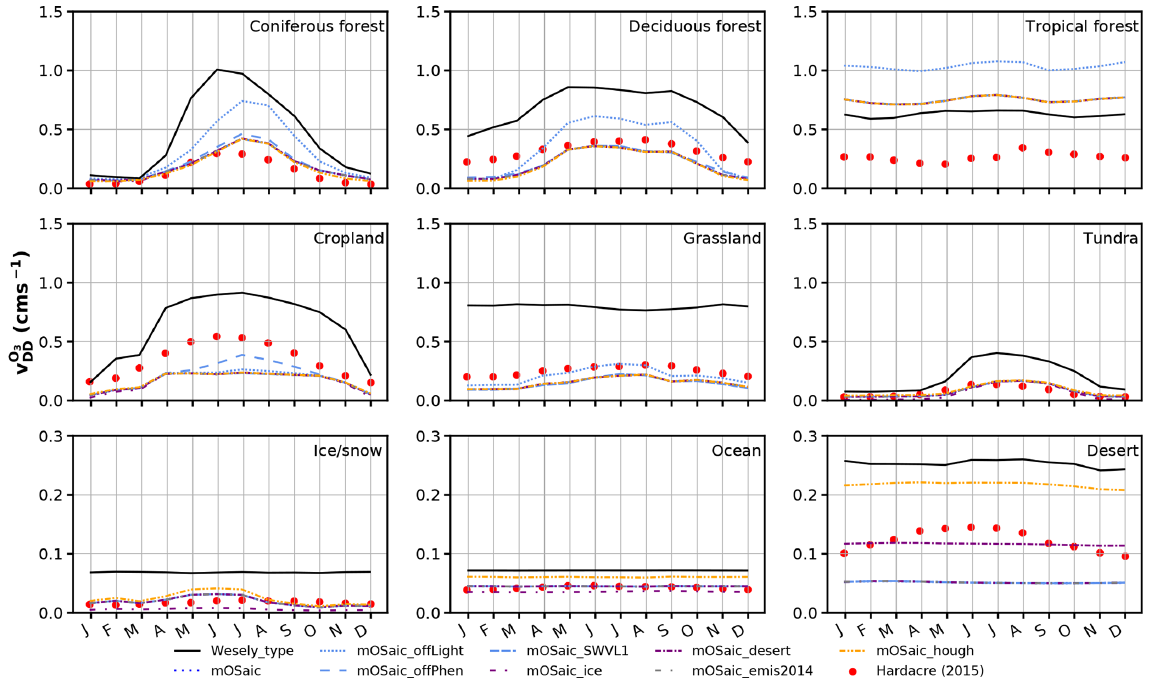
Figure 7. Average seasonal cycles of ozone dry deposition velocities separated by land use type. Results from Hardacre et al. (2015) are shown as a reference. We refrain from showing the full extent of EMEP_offLight here, since it is an extreme scenario and has been discussed already. Table 3. Total ozone dry deposition for the respective model experiment in Tga − 1 . The global ozone dry deposition has been weighted by ocean, ice, and land fraction in each grid box, respectively. “Ice” herein refers to regions at high latitudes that are permanently covered by ice and